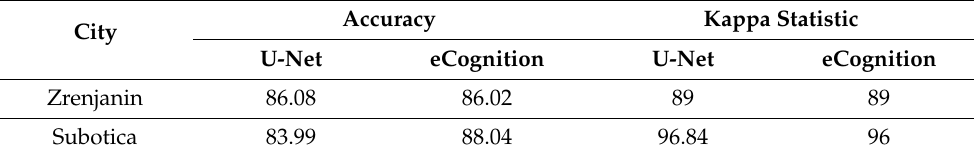
Table 3. Accuracy Table 3. Accuracy assessment.